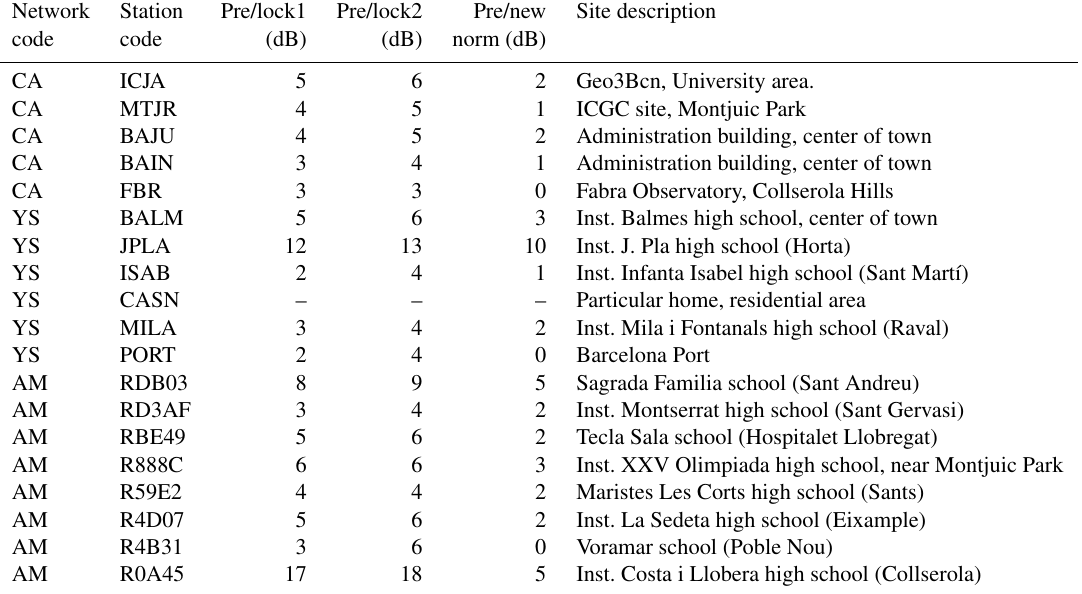
Table 1. Site description and differences in power amplitude observed between the different lockdown phases for all investigated seismic sta- tions. Pre/lock1: power amplitude difference between normal period and lockdown phase 1. Pre/lock2: power amplitude difference between normal period and lockdown phase 2. Pre/new norm: power amplitude difference between normal period and “new normality” period. See text for the